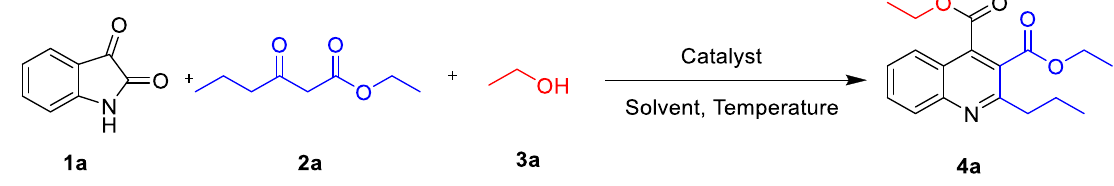
Table 1. Optimization of reaction conditions for synthesis of compound 4a a .